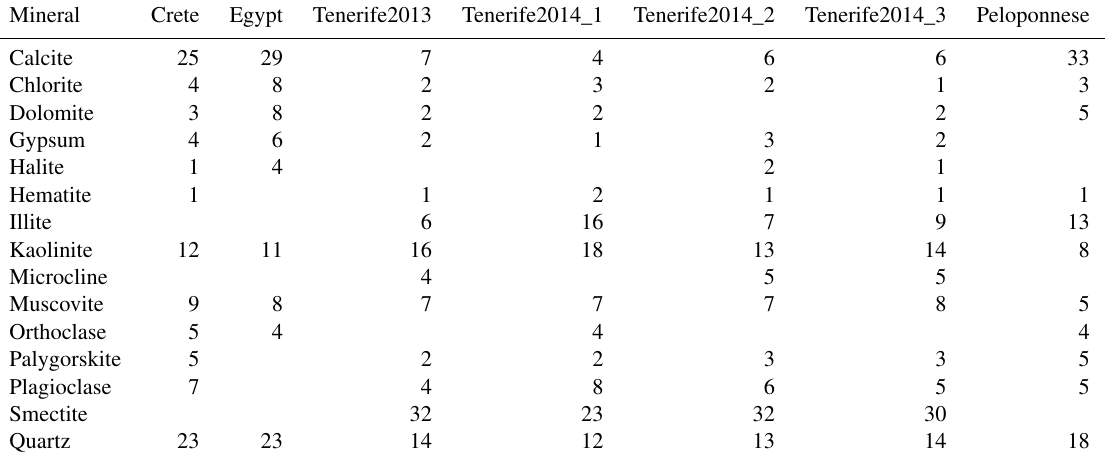
Table 1. Mineralogical composition in wt% of airborne Saharan dust samples. Crete, Egypt, Tenerife2013 (Tenerife in Part 1), and Pelo- ponnese as in Boose et al. (2016c). Results were rounded to the nearest integer from the original Rietveld fit results, thus total composition (cid:54)= 100wt% may